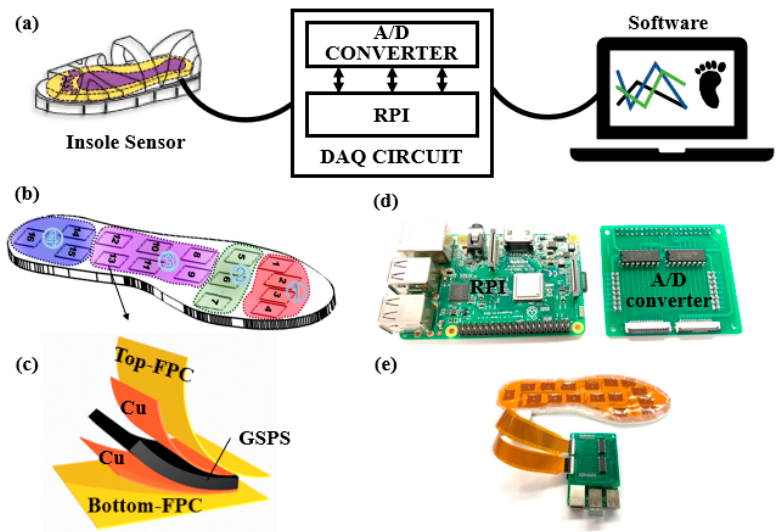
Figure 2. The smart sole system. ( a ) Measurement system. ( b ) Four regions of the insole-shaped FPC. Region one includes the hallux (1), 2nd toe (2), 3rd toe (3), and the 4th and 5th toes (combined) (4). Region two include the 1st, 3rd, and 5th metatarsus. Region three (8~13) and four (14~16) represent the midfoot and heel, respectively. ( c ) Structure of the insole sensor. ( d , e ) Photographs of the RPI, A/D converter, and DAQ system.